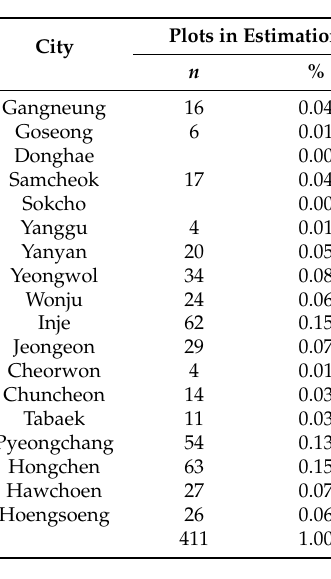
Table A1. Plot distribution comparison before and after the filtering